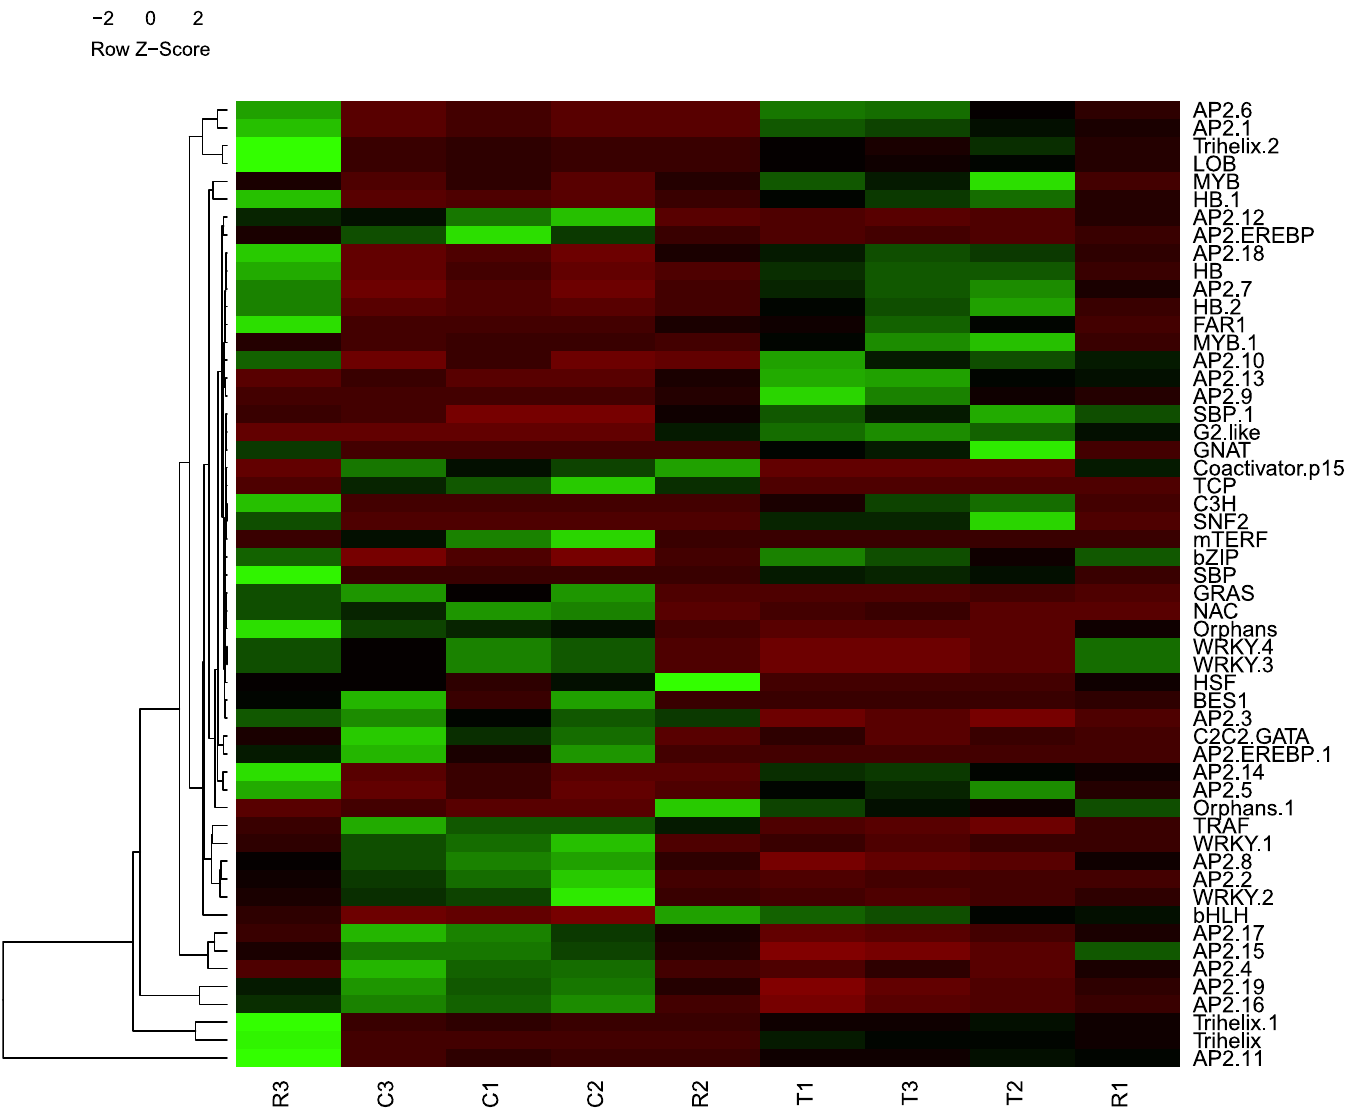
Fig 6. Transcription factor clustering heat map ( P < 0.05). Colors indicate the range of log 10 (FPKM+1) values from small (red) to large